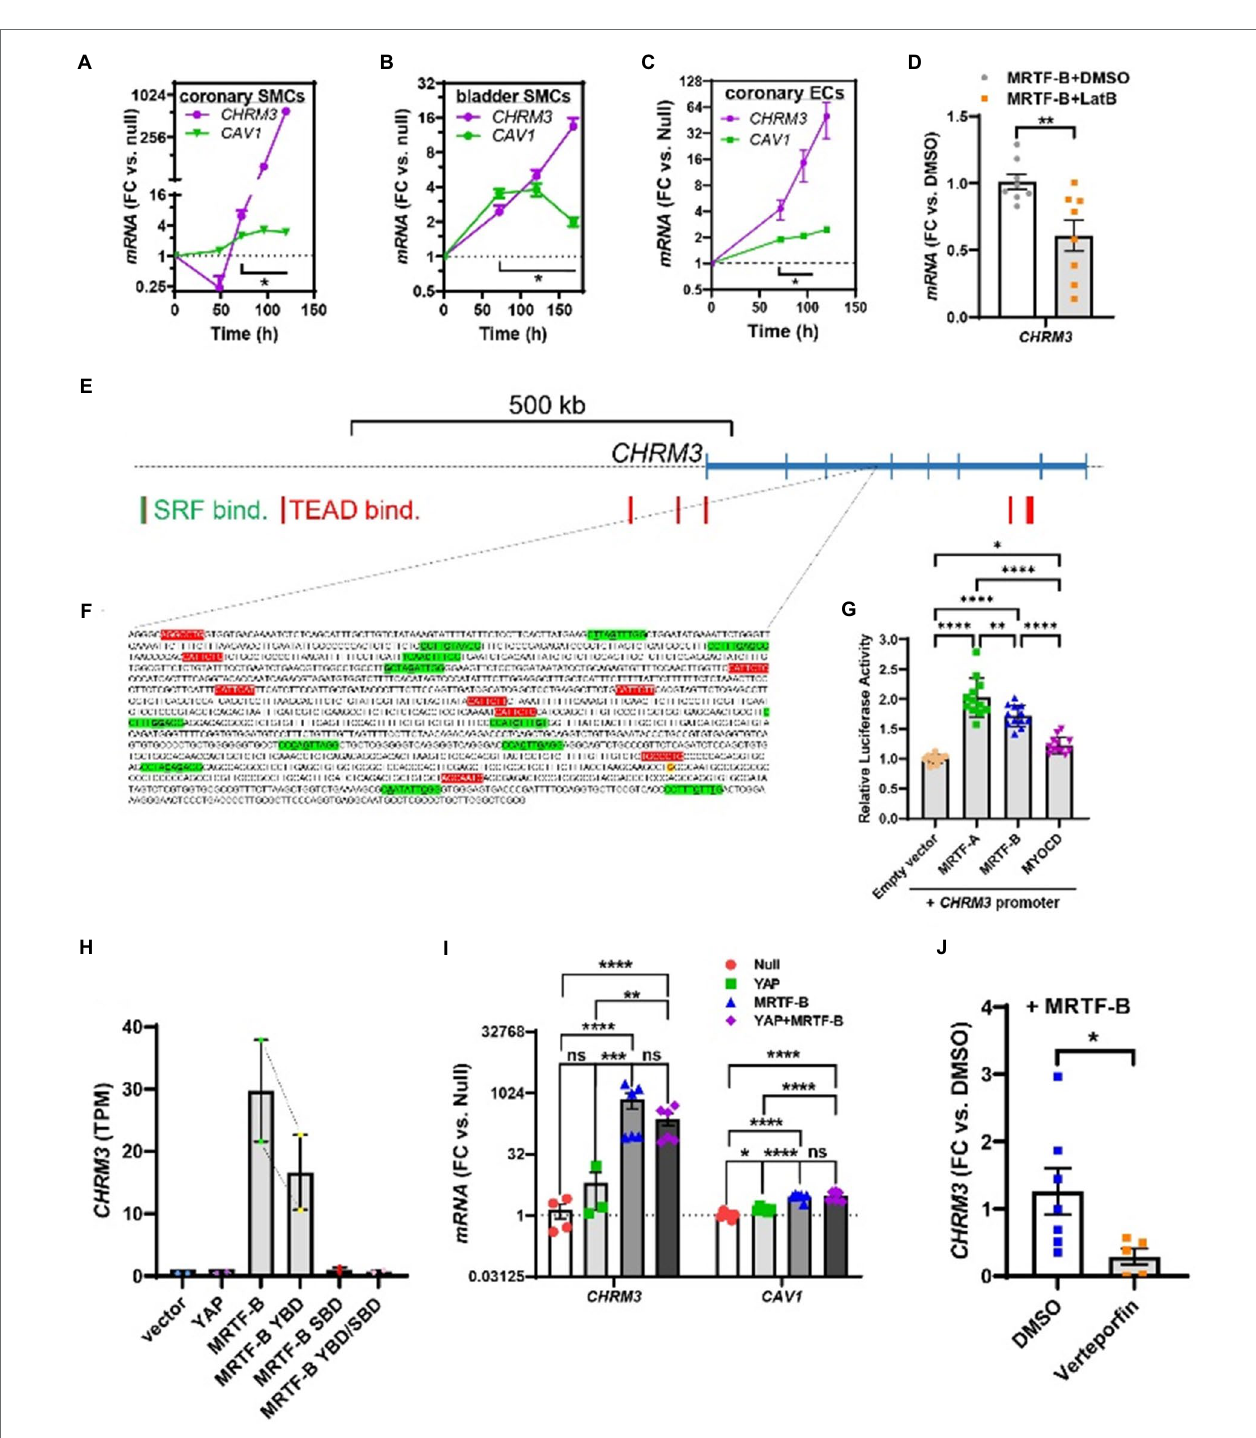
FIGURE 3 | Time-course data, promoter reporter assays, and MRTF-B-YAP cooperation. MRTF-B was overexpressed in different cell types (200 MOI), and cells were harvested at different times. RNA was subsequently isolated, and CHRM3 was measured by RT-qPCR. (A) Shows time-dependent upregulation of CHRM3 in human coronary artery SMCs. Significant increases were seen at times exceeding 48 h, and a 597-fold increase was seen at 120 h ( p = 0.0004, n = 3). Because there was no indication that the increase of CHRM3 reached a plateau at longer transduction times, we designed an experiment using even longer incubations in human bladder SMCs (B) . Again, there was no tendency of a plateau. Moreover, the maximal increase was somewhat smaller than in coronary artery SMCs. Similar results were obtained in human coronary artery endothelial cells [ (C) , 200 MOI]. (D) Shows that CHRM3 was reduced by Latrunculin B (100 nM, gray bar) in MRTF-B- transduced ECs. Inspection of the CHRM3 gene locus on chromosome 1 (E) revealed SRF binding (green vertical bars) and TEAD binding (red vertical bars) to many sequences 5 ' of, and over, the longest transcript (blue). Direct examination of a commercial promoter reporter sequence (NM_000740, transcript variant 2,